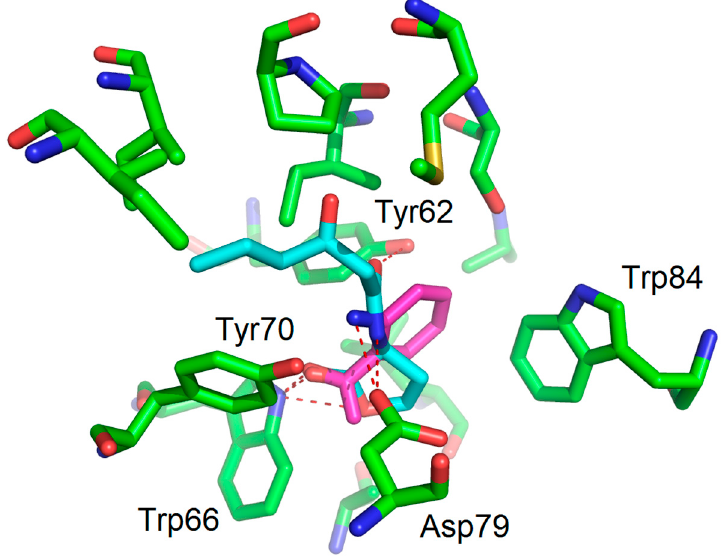
Figure 8. The binding mode (molecular docking) of 2-AA (magenta) within the LuxR model binding site. OHHL is also represented, in cyan. site. OHHL is also represented, in